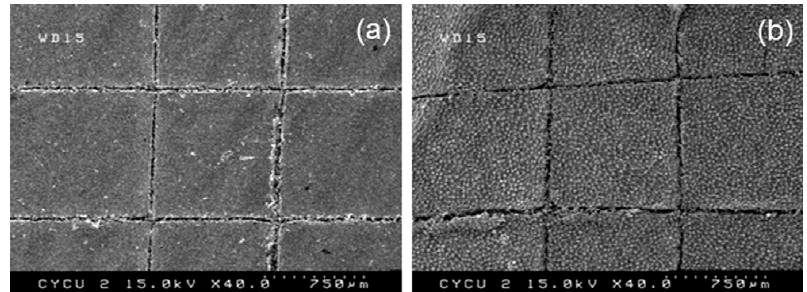
Figure 4. SEM images of ( a ) F-PANI coated on CRS and ( b ) SH-PANI coated on CRS after testing for adhesion. Reprinted from [73] with permission; Copyright Elsevier 2013.